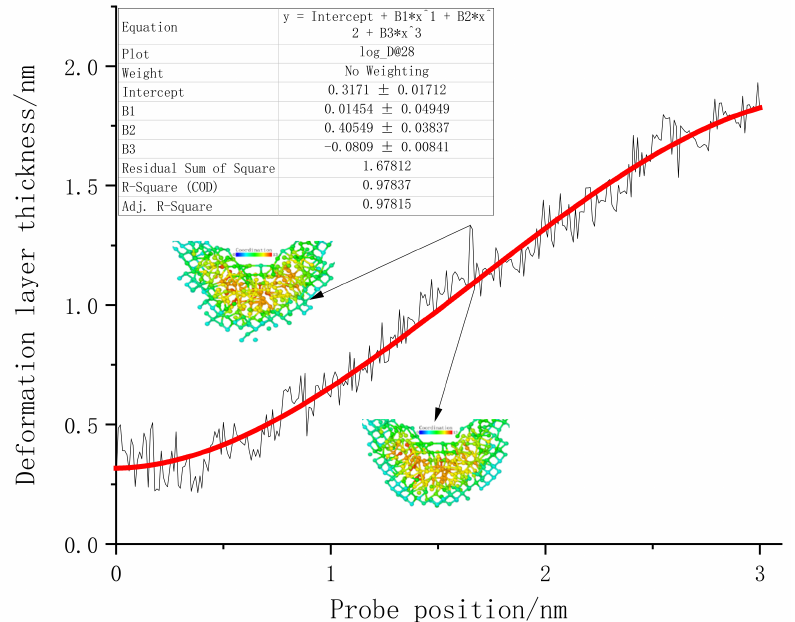
Figure 15. The relationship between the deformation layer and the depth of loading when the (001) surface was